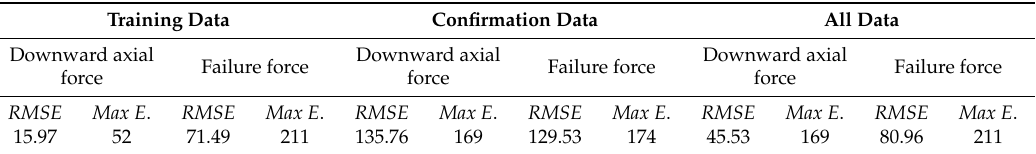
Table 5. The RMSE and maximum error for the training data, the confirmation data and the overall data when the architecture of the neural networks is 10-8-1.